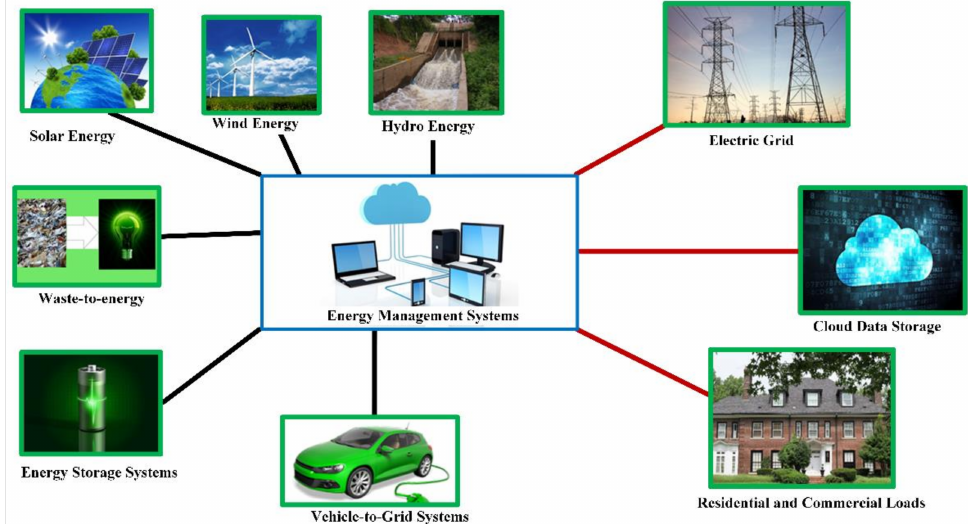
Figure 9. Energy management